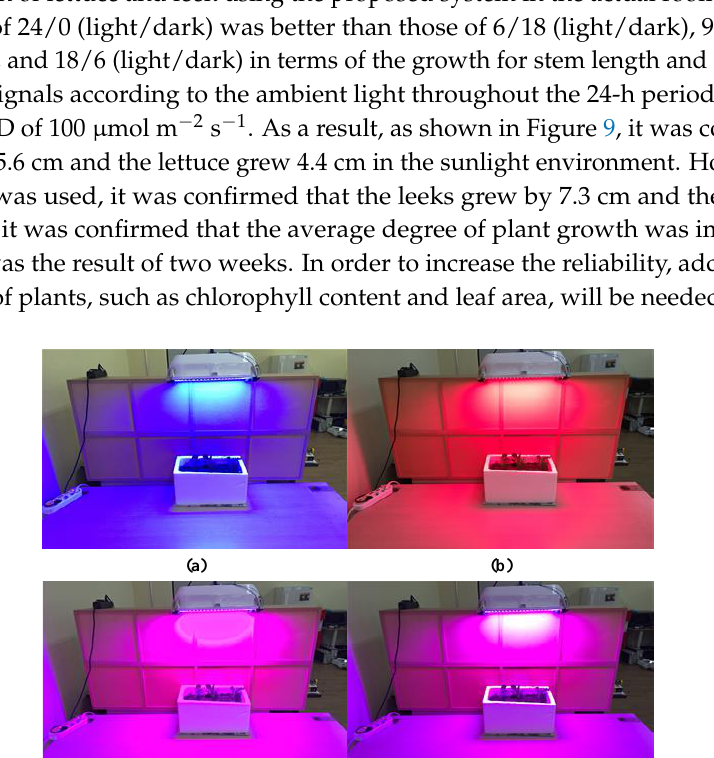
Figure 8. Plant cultivation test for the proposed LED control system using red/blue LED PWM signals: ( a ) 0/255; ( b ) 255/0; ( c ) 128/128; and ( d ) 255/255.